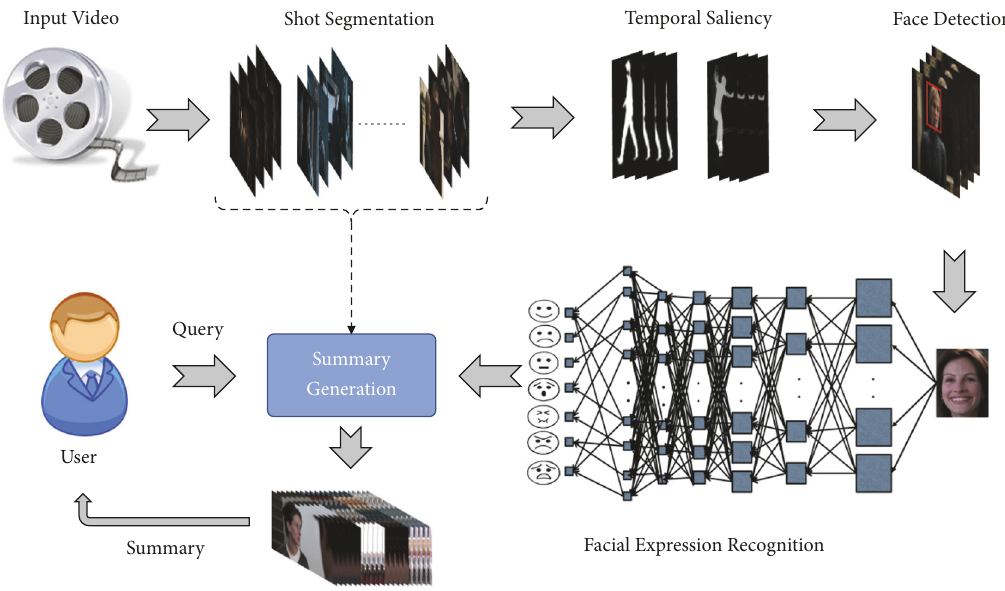
Figure 1: Overall framework of the proposed movie summarization